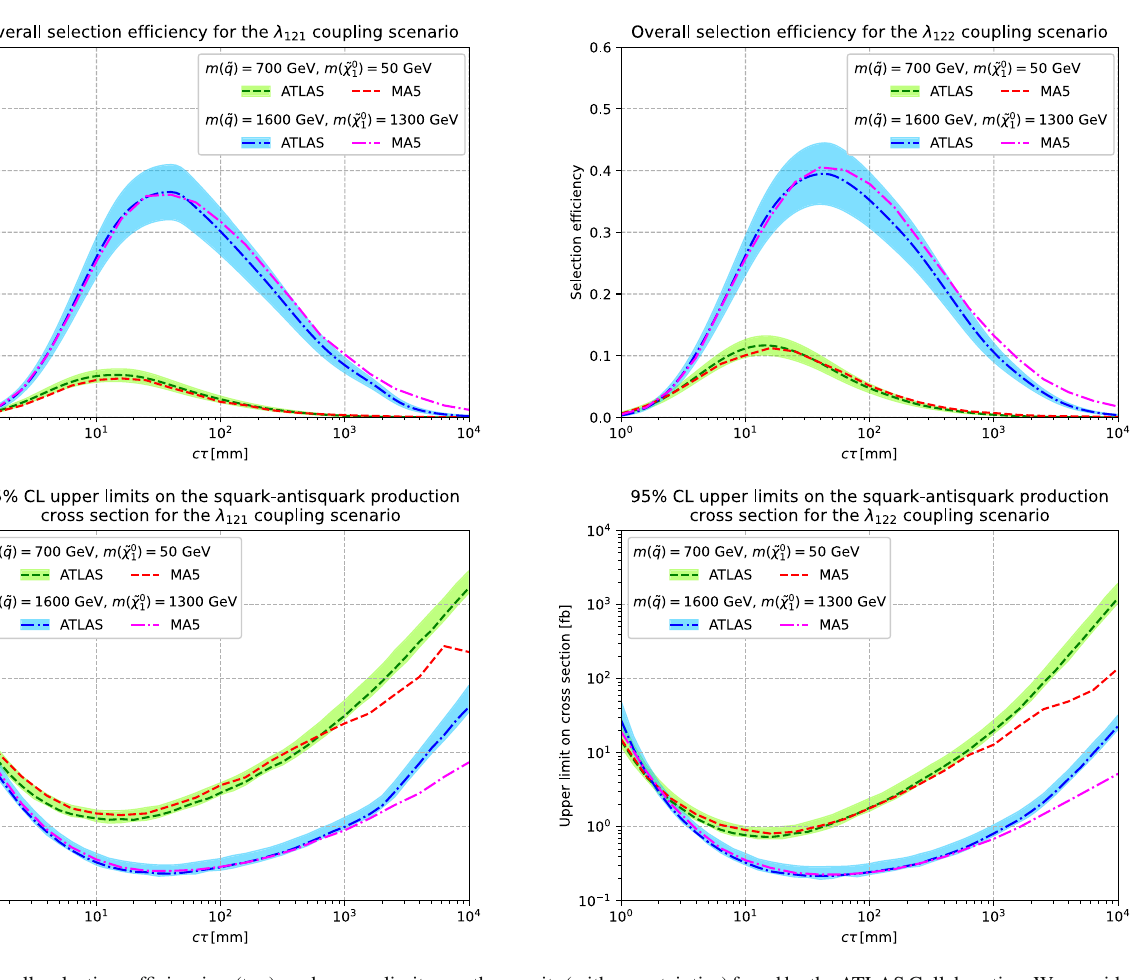
its(withuncertainties)foundbytheATLASCollaboration.Weconsider twoconfigurationsofsquarkandneutralinomassesinthe λ 121 (left)and λ 122 (right) coupling